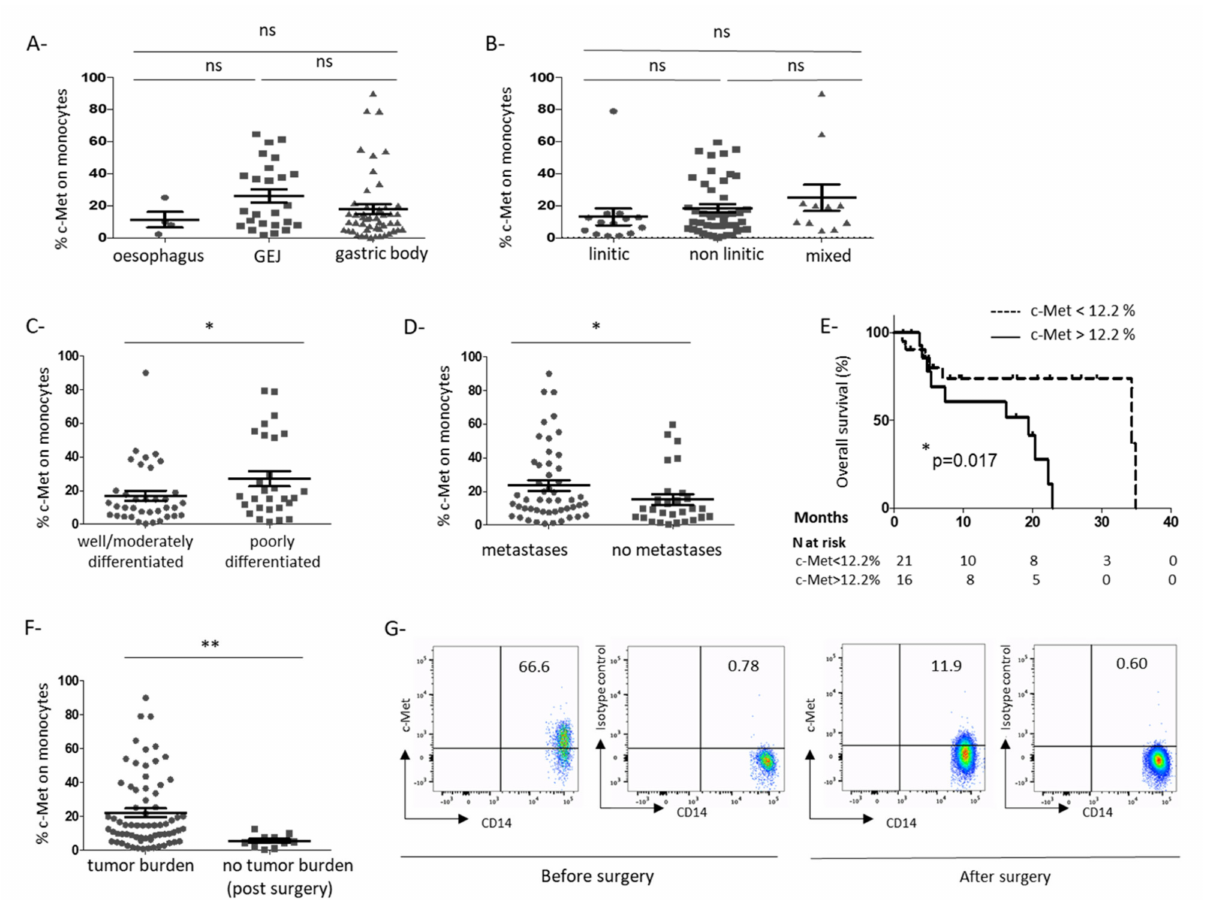
Figure 2. The C-Met expression on circulating monocytes is associated with an aggressive disease phenotype in GC patients. Clinical and pathological characteristics of the GC patients included in our cohort were analyzed ( n = 80) ( A – D , F ). C-Met expression was assessed by flow cytometry as in Figure 1. Mean c-Met expression on circulating monocytes according to tumor location (esophagus, gastro–esophagic junction (GEJ), gastric body) ( A ), linitic status ( B ), tumor differentiation ( C ), presence of metastases ( D, ) and presence of an evolutive tumor burden ( F ). * indicates a p -value ≤ 0.05 and ** indicates a p -value ≤ 0.01 according to the Mann-Whitney test. NS: nonsignificant ( E ) For 37 patients who had received 1 or 0 cycles of chemotherapy before assessment of c-Met expression, survival probability has been estimated according to c-Met expression level on monocytes (high expression > median n = 16 (full line), lower expression < median, n = 21 (dashed line)). The median was calculated on the global population. ( p = 0.017 according the Log-rank test). ( G ) For one patient with a localized tumor, the c-Met expression on circulating monocytes was assessed by flow cytometry before and after tumor resection (gastrectomy). Results are indicated as percentages of c-Met positive